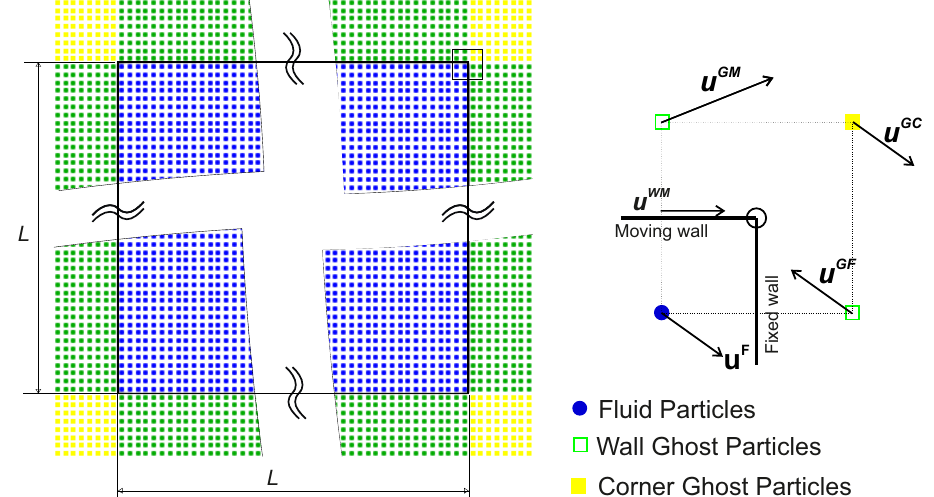
Figure 21. 2D Lid-driven cavity flow: Layout of the particles and treatment of ghost particles in